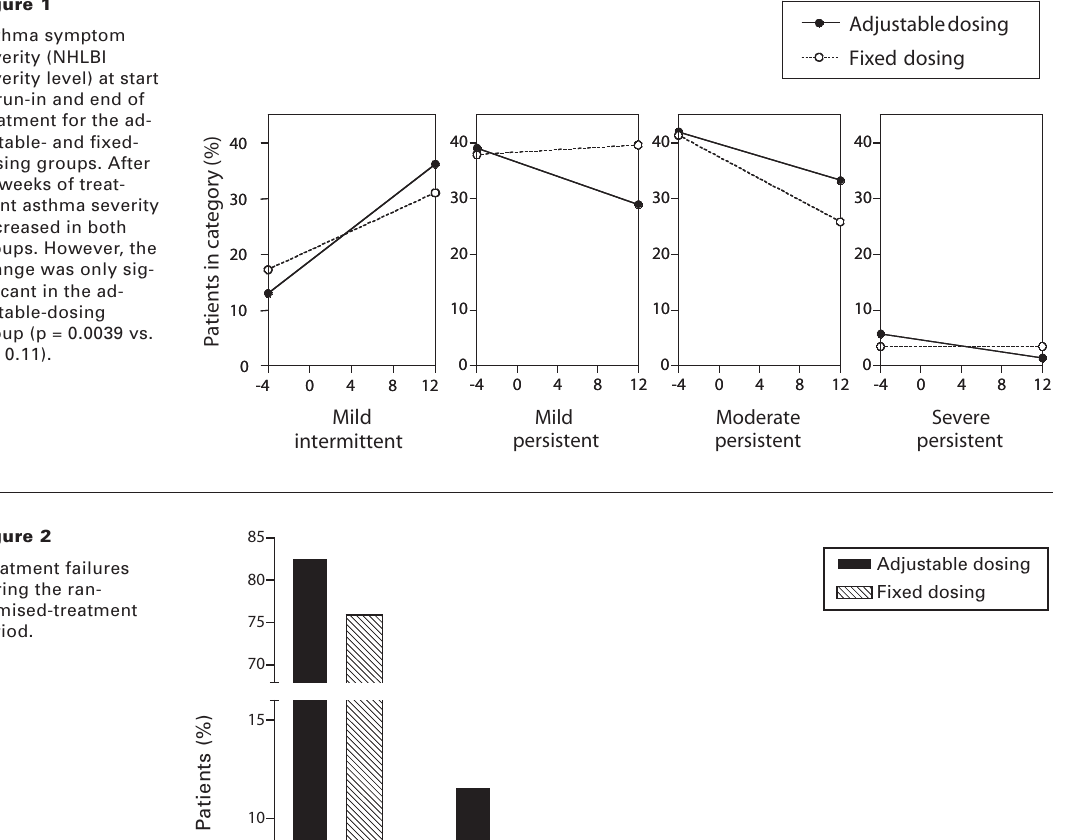
Treatment failures during the ran- domised-treatment period.